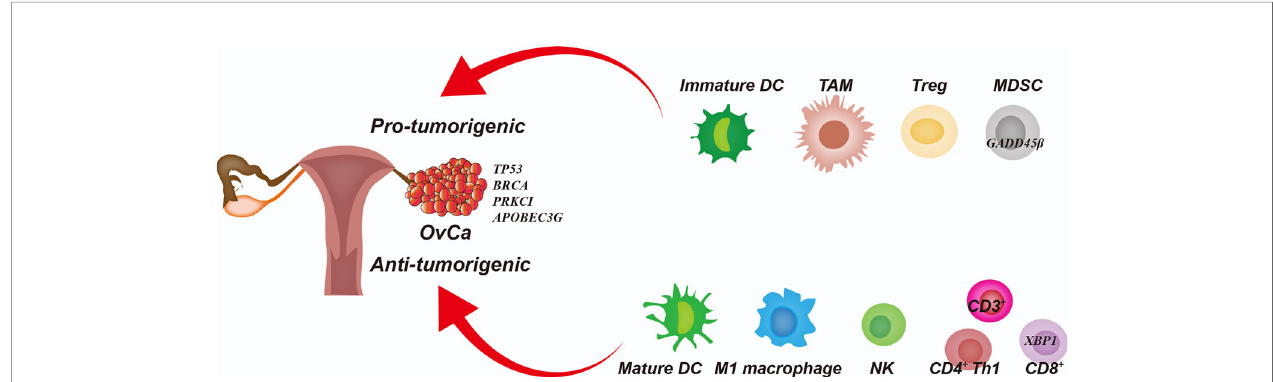
FIGURE 1 | Interplay Among Cancer Cells and Immune Cells in the Ovarian Cancer Tumor Microenvironment. The immature dendritic cells (DCs), tumor-associated macrophages (TAMs), regulatory T cells (Tregs) and myeloid-derived suppressor cells (MDSCs) promote immunoresistance and therapeutic resistance in the ovarian cancer (OvCa) cells. Mature DCs, M1 macrophages, natural killer (NK) cells, and cytotoxic T lymphocytes (CTLs) inhibit tumor growth and increase the therapeutic susceptibility of OvCa